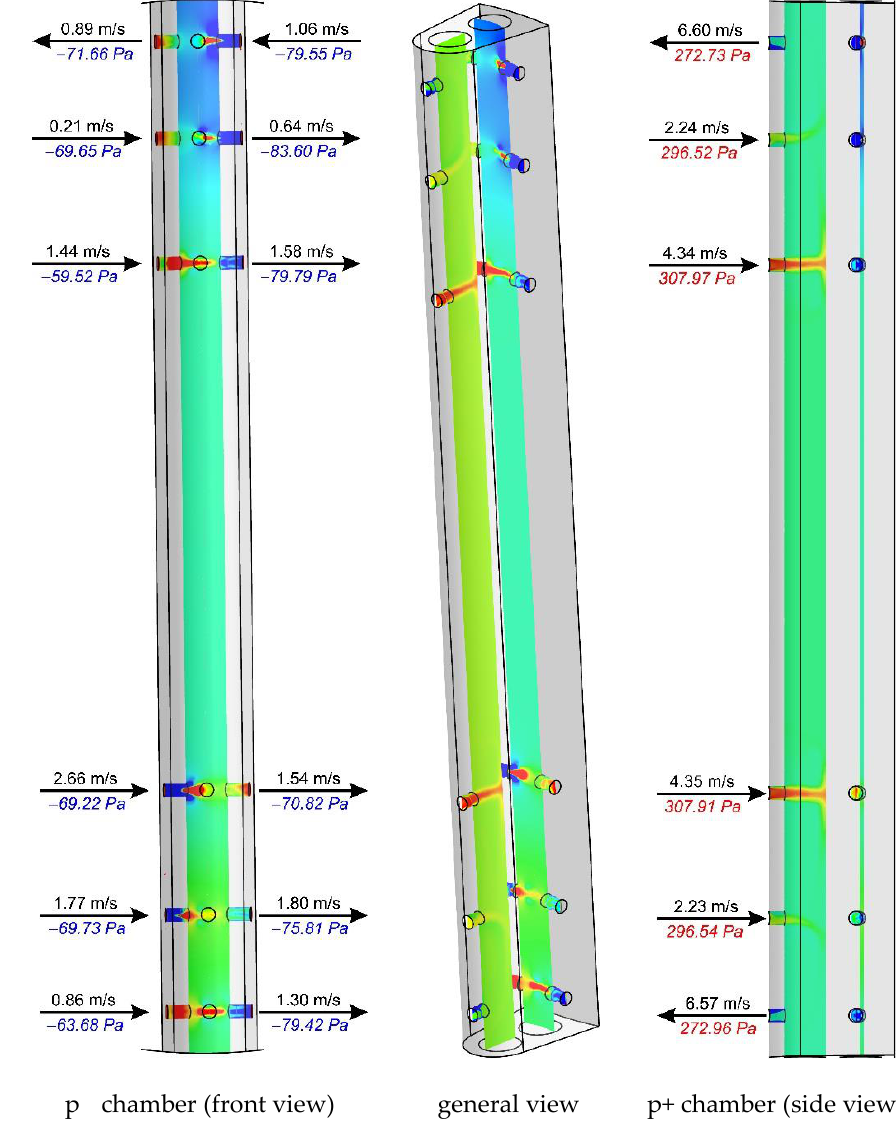
Figure 12. Fluid velocity and total pressure in planes of the bore holes downstream of an elbow (x/D = 10) with curvature R c = 1D.